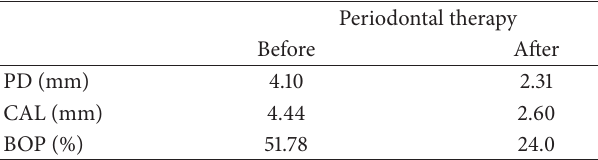
Table 1: Clinical features before and after the periodontal therapy. Periodontal